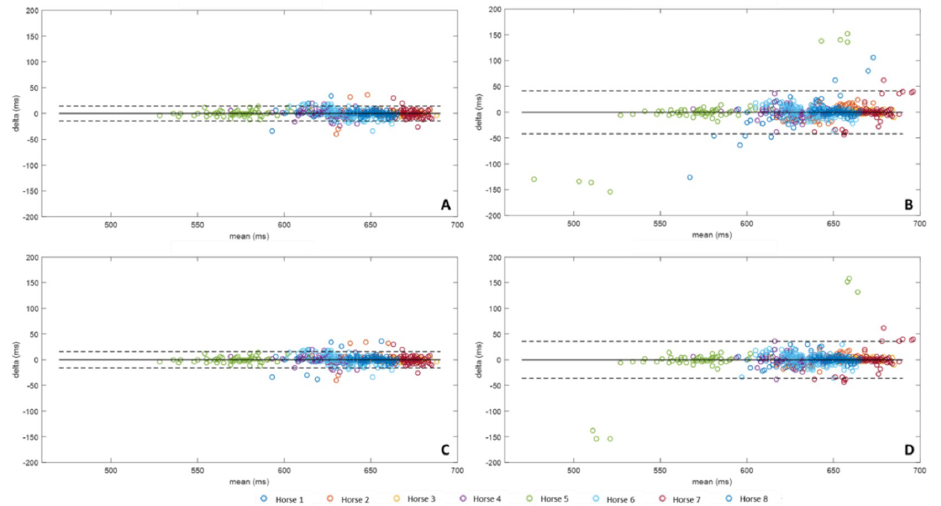
Figure 7. Bland-Altman comparison of the Stride Duration , calculated from the Foot on obtained from the four methods developed with IMU data and MoCap. Accuracy (bias between each method and MoCap) and limits of agreement (95% limits of agreement) of method A were represented on the upper left corner ( A ), method B on the upper right corner ( B ), method C on the lower left corner ( C ), and method D on the lower right corner ( D